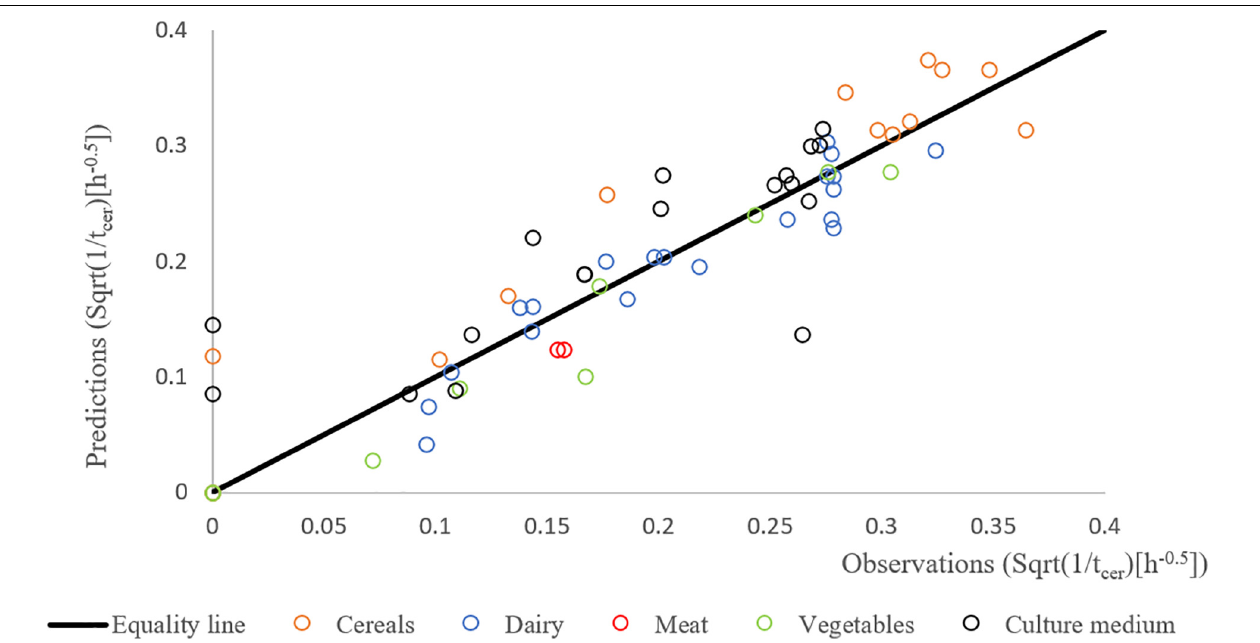
FIGURE 6 | Predicted vs. observed square root (Sqrt) of 1/t cer for the different strains of the validation study in the different matrices: BHI (black), cereal- (orange), dairy- (blue), meat- (red), and vegetable-based matrices (green).